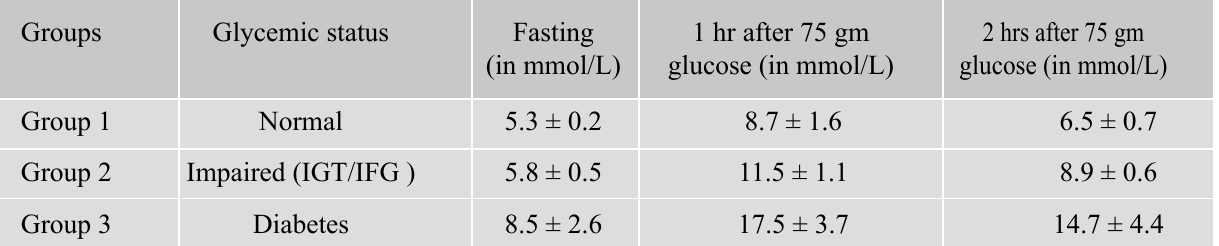
Table IV: Mean plasma glucose levels during OGTT in different groups of glucose homeostasis (normal, impaired and